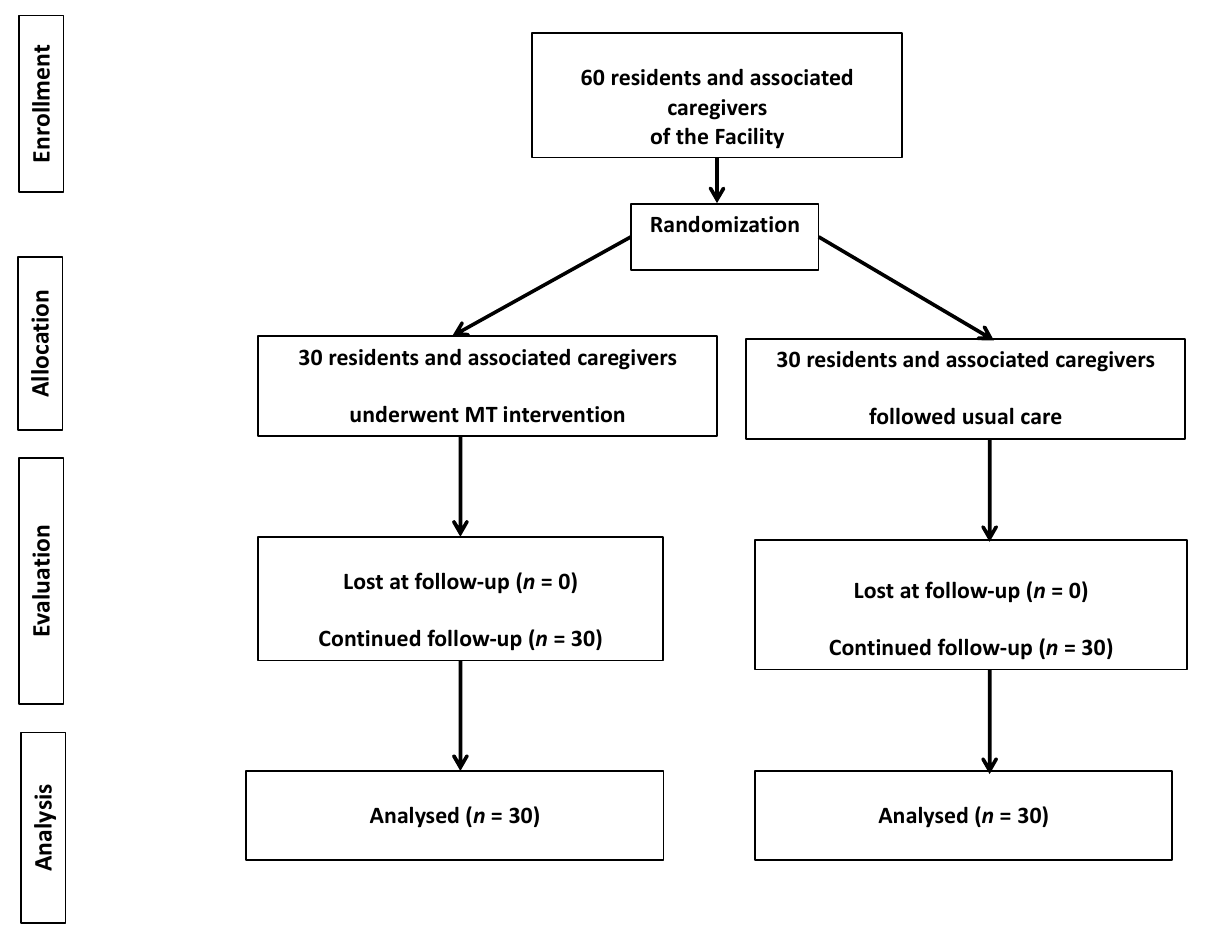
Figure 1. The study flow